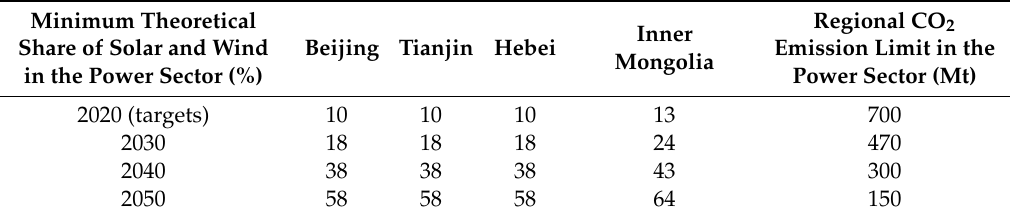
Table 8. Assumed theoretical solar and wind shares in the power sector by model region and regional CO 2 emission